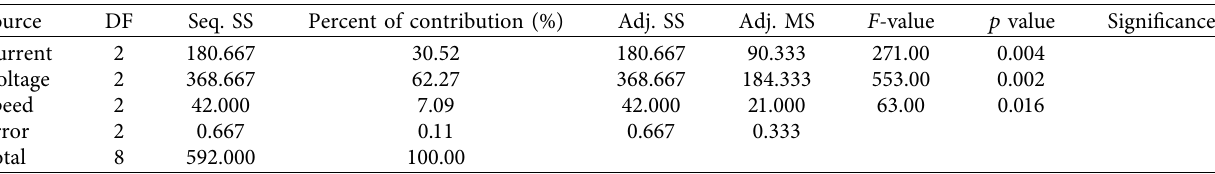
Figure 8: Plot of residual versus fitted hardness of weld zone values. Table 8: General linear model of hardness of weld zone versus current, voltage, and speed for